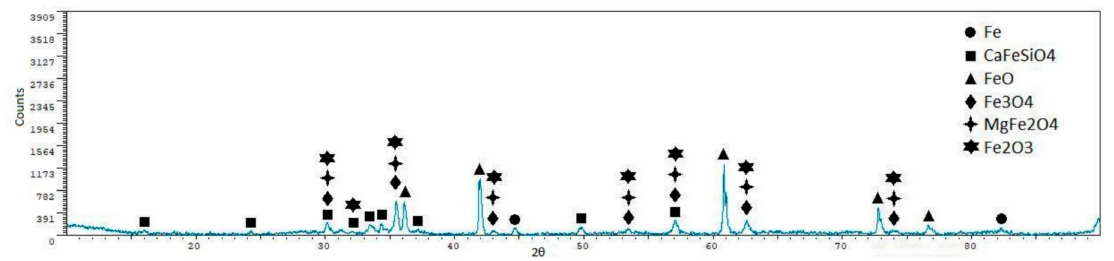
Figure 21. X-ray diffraction pattern for the sample BF3.